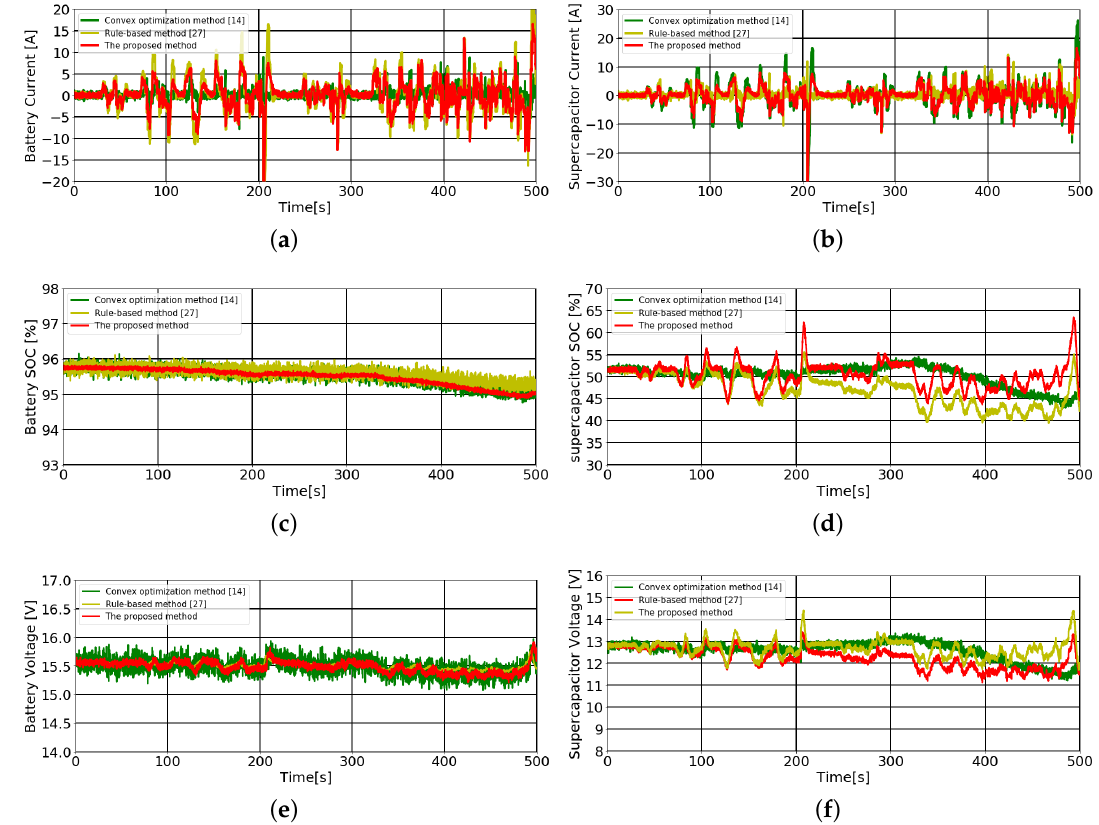
Figure 10. The proposed method, the real-time frequency-based method [27], and the off-line optimization method [14] on the LA92 dynamometer driving schedule. ( a ) Current of battery profiles; ( b ) Current of supercapacitors profiles; ( c ) SOC of battery profiles; ( d ) SOC of supercapacitors profiles; ( e ) Voltage of battery profiles; ( f ) Voltage of battery